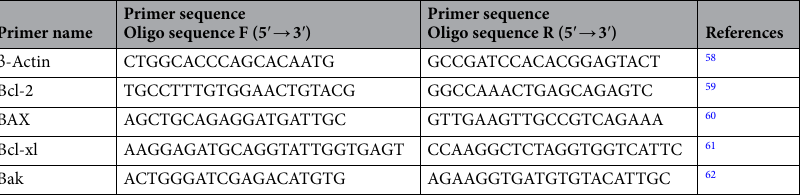
Table 1. Primers used for β-actin, Bcl-2, BAX, Bcl-xl, and Bak genes in the present study.